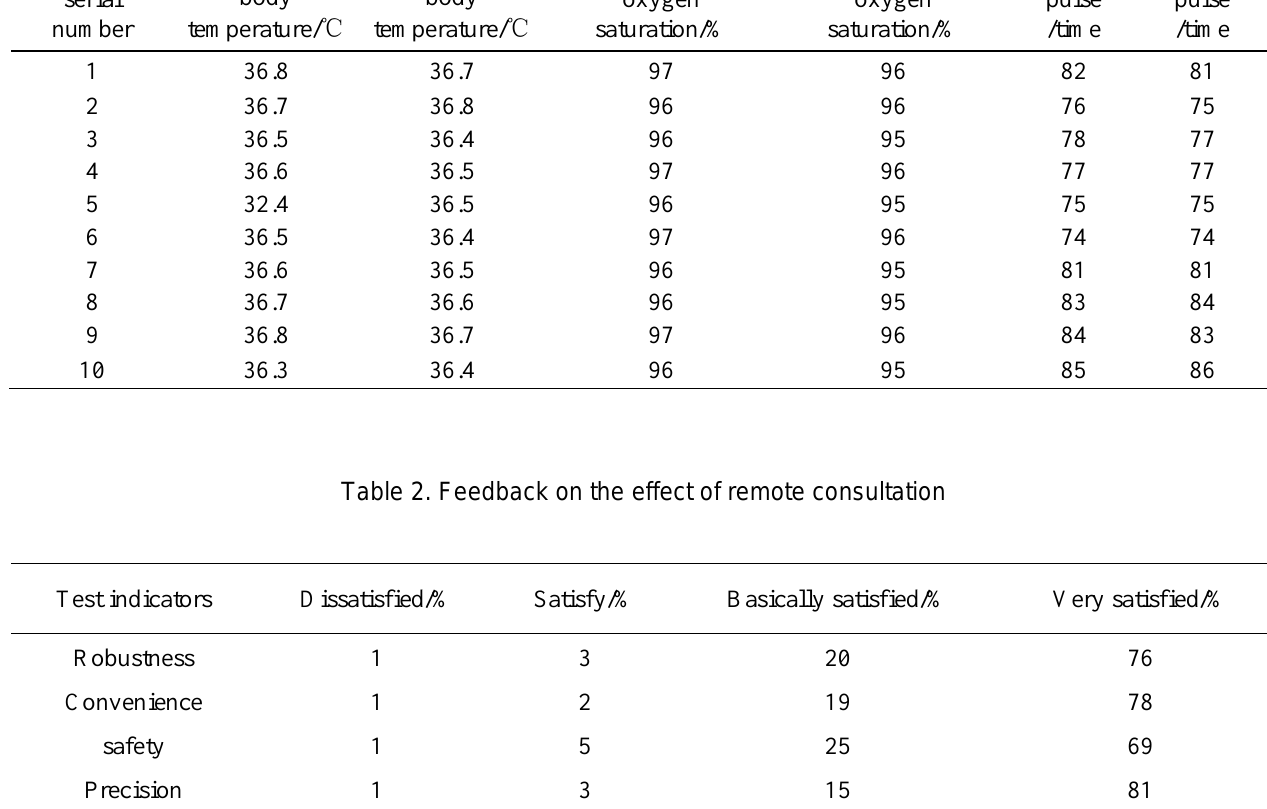
Table 1. The monitoring results of remote consultation the system in this paper